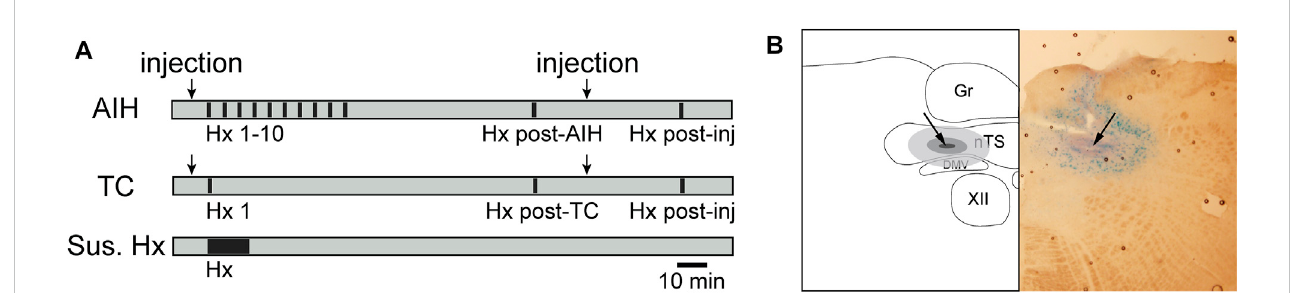
FIGURE 1 Timeline of general hypoxic experimental protocols (A) and example nTS injection site (B) . (A) AIH: Animals exposed to AIH undergo 10 bouts of hypoxia (Hx,45s;blackbars)separatedby5 minbreathingO 2 enrichedair(grey).1 hour followingtheconclusionofHx10,theyunderwenta fi nalboutofHx(Hxpost- AIH). TC: Time control (TC) animals received only the fi rst (Hx 1) and fi nal (Hx post TC) bout of hypoxia. Separate groups of rats received nTS nanoinjections (arrows)ofmuscimoloraCSF,eitherpriortoHx1orfollowingtheAIHorTCprotocol.MuscimolinjectionsafterAIHorTCwereonlygiveninratsthathad nointerventionoraCSFinjectionspriortoAIH.Ratswerethensubjectedtoanotherboutofhypoxia(Hxpost-inj).Asanadditionalcontrol,ratsweresubjected to one period of sustained hypoxia (Sus. Hx) of the same total duration as the combined time in Hx 1 – 10. (B) schematic representation (left) and photomicrograph (right) of a coronal brainstem section ( − 150 µm to calamus scriptorius) showing the center of the injection site (arrow). Gr, gracile nucleus; nTS, nucleus tractus solitarii; DMV, dorsal motor nucleus of the vagus; XII, hypoglossal